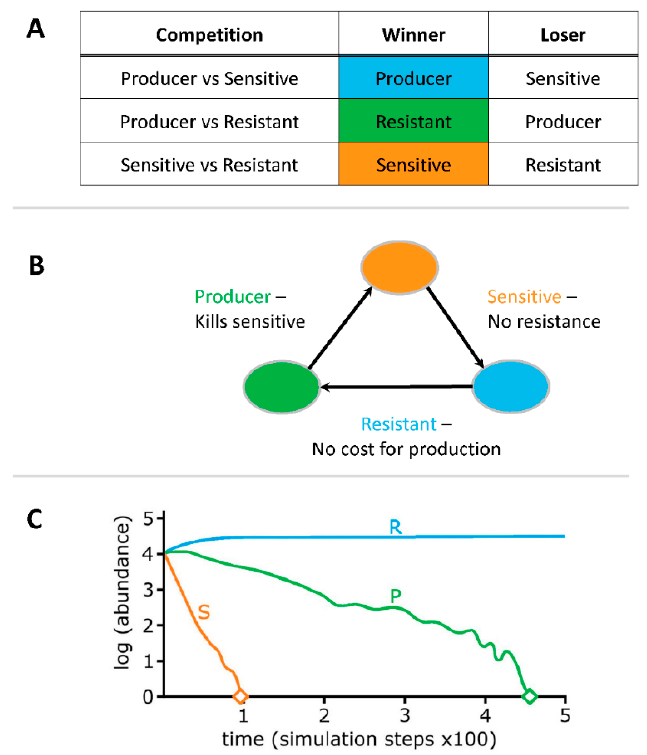
Figure 1. “Rock-Paper-Scissor” game of competition dynamics. Note: R = resistant, P = producer and S = Sensitive. Compartments ( A ), ( B ) and ( C ) are adapted from references [6–8], respectively.